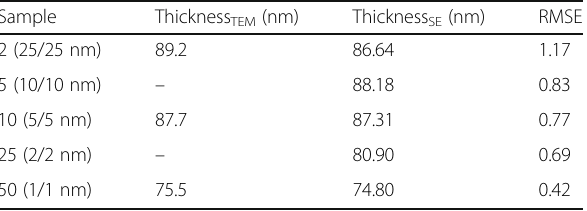
Table 2 The thicknesses of AZO layer obtained from TEM and fitted by SE, and the fitting error RMSE Sample Thickness TEM (nm)